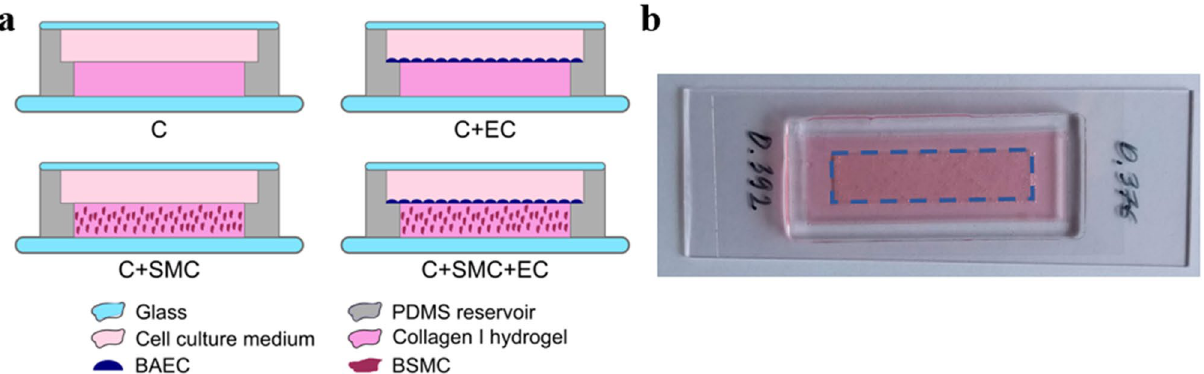
Figure 1. ( a ) Schematic drawing of the four types of analyzed samples: collagen I hydrogel alone (C); (i) collagen I hydrogel covered with ECs (C + EC); (ii) collagen I hydrogel containing SMCs (C + SMC); (iii) collagen I hydrogel containing SMCs and covered with ECs (C + SMC + EC). ( b ) Photograph of a typical sample after preparation. The central rectangle (0.75 cm × 3 cm) corresponds to the collagen hydrogel location